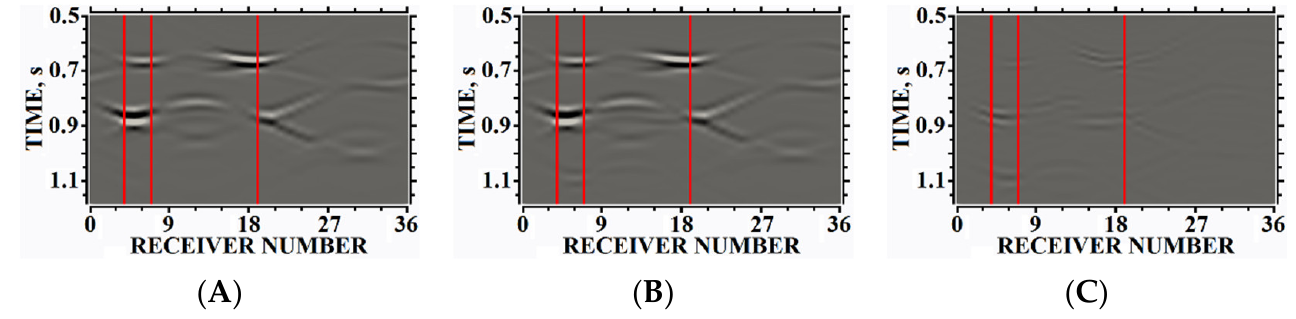
Figure 11. Seismograms, Y-component of the anomalous velocity: ( A ) with overlapping curvilinear mesh; ( B ) without overlapping curvilinear mesh; ( C ) difference.